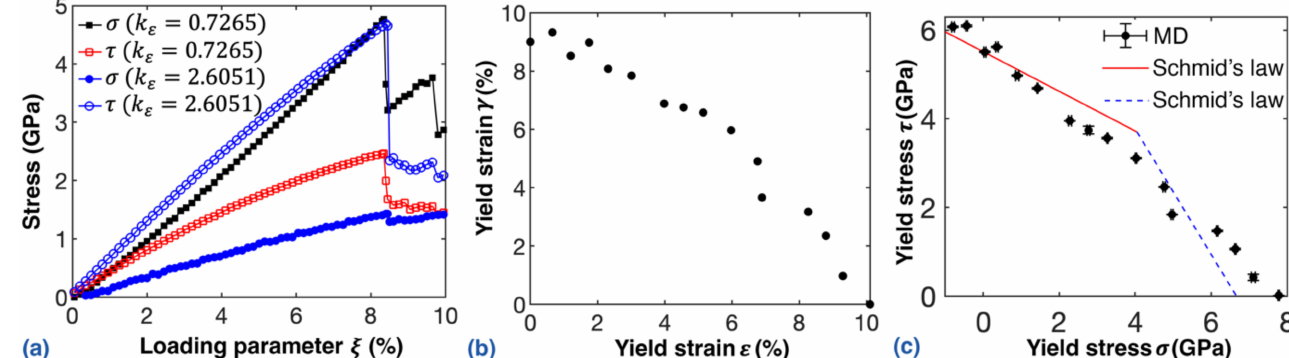
Figure 1. The mechanical properties under different torsion/tension strain ratios: ( a ) stress-loading parameter curves of the Cu NW with two torsion/tension strain ratios k ε ; ( b ) yielding strain pattern; and ( c ) yield stress pattern. The solid and dashed lines are fitted following Schmid’s law using the nonlinear least square